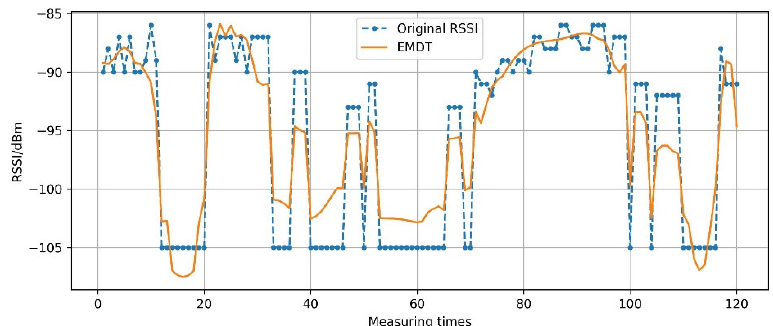
Figure 12. Abnormal situation.